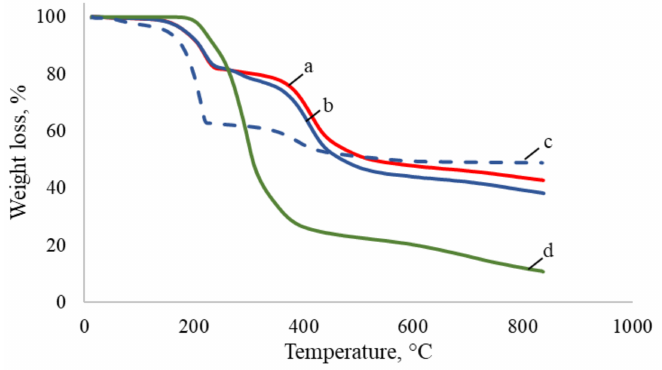
Figure 8. TGA curves: a—PyrSMC with 10% Pyr and OD:TPM 1:4; b—blank SMCs with OD:TPM 1:4; c—blank SMCs with OD:TPM 2:3; d—pyraclostrobin of technical